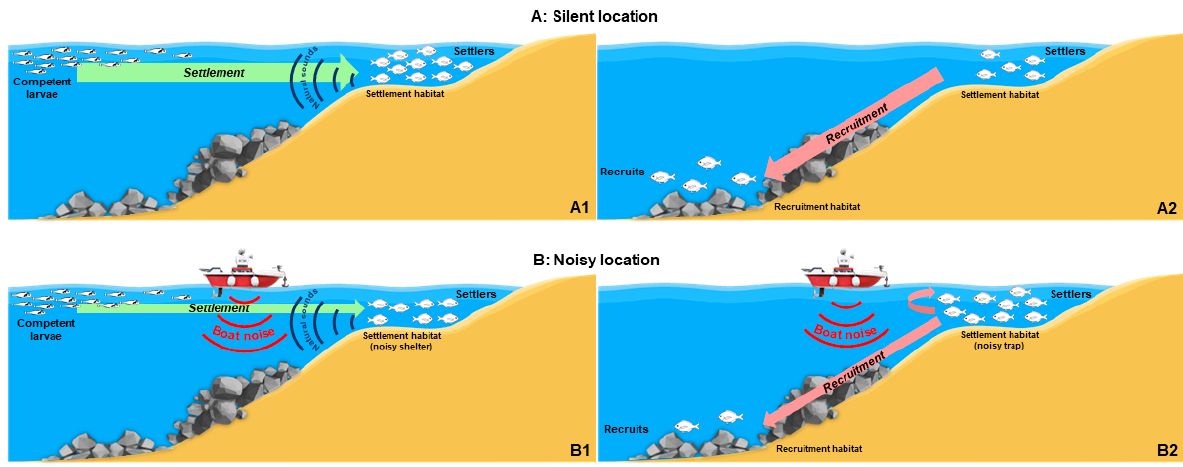
Figure 7. Schematic representation of the hypothesis proposed in this study. In silent conditions (panel ( A1 )), competent larvae use the natural sound cues to reach a suitable settlement habitat/site (green arrow), and then ( A2 ) late post-settlers leave the settlement habitat/site (pink arrow) to recruit into the adult population. MNP caused by boat traffic ( B1 ) masks the natural sound cues used by competent larvae to reach the suitable settlement habitat/site, thus reducing settlement intensity, and then ( B2 ) late post-settlers are disturbed by boat noise when they should leave the settlement habitat/site, which could reduce and delay recruitment and cause unnaturally higher late post-settler abundances in settlement